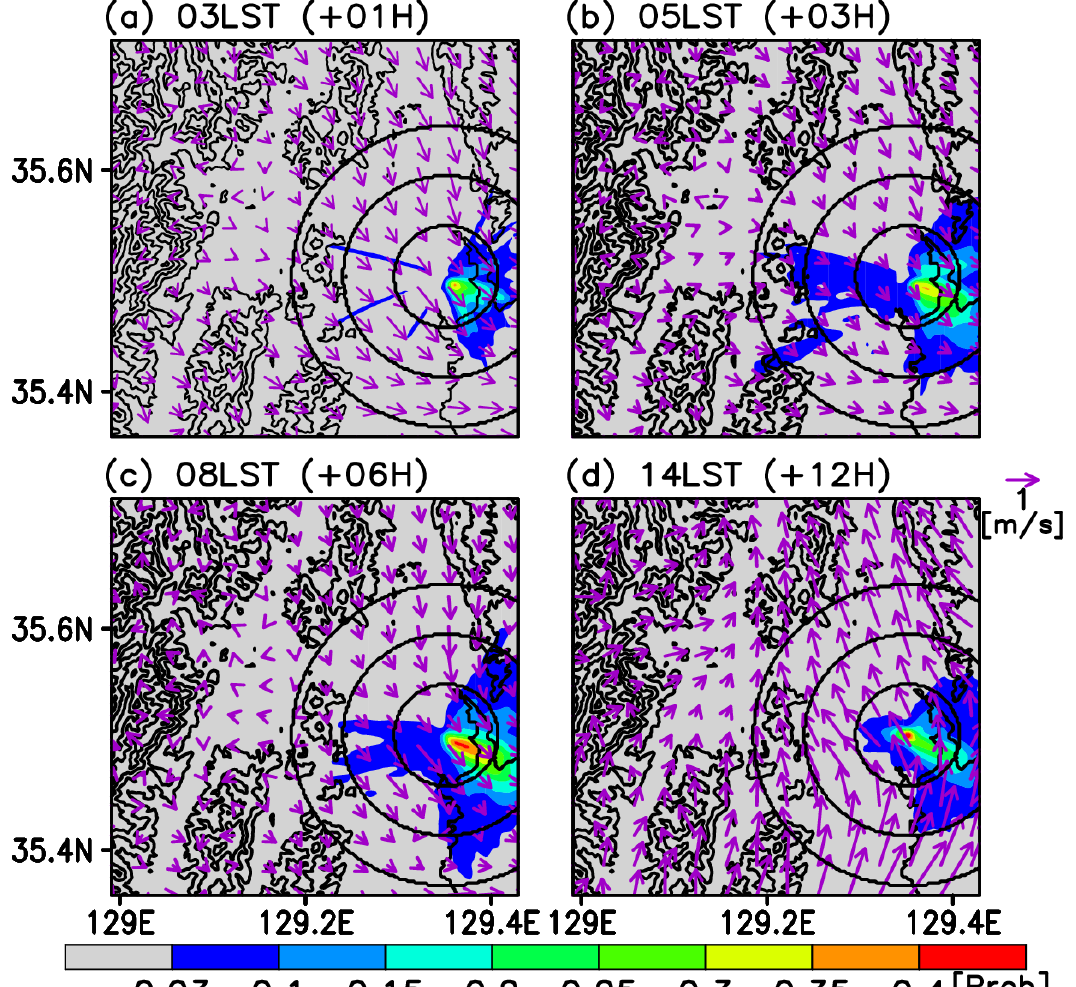
Figure 8. Time ‐ organized hit rate of benzene concentration exceeding 30 ug m ‐ 3 (shaded) at each grid point and surface wind (arrow, unit: m s − 1) of the nighttime emission ‐ started cases. Hit rate is defined as the total count of the case divided by the elapsed hour from the emission starting time and the total number of the day. Each panel shows the patterns at ( a ) 03:00 LST, ( b ) 05:00 LST, ( c ) 08:00 LST, and ( d ) 14:00 LST, which are 1, 3, 6, and 12 h after the emission starts, respectively. Also shown is the topography (contour in black). Three circles indicate the distance from the emission source to 5, 10, and 15 km.